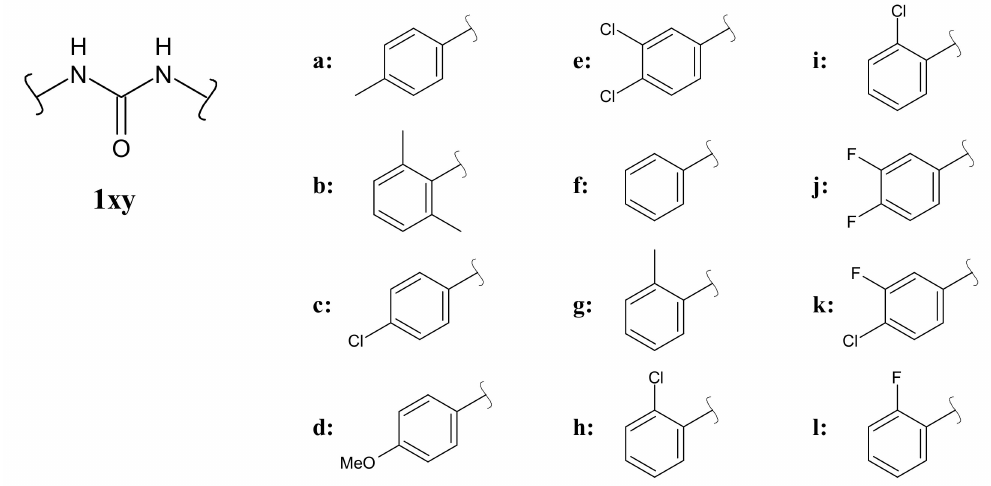
Figure 2. Diarylureas ( a – l ) under